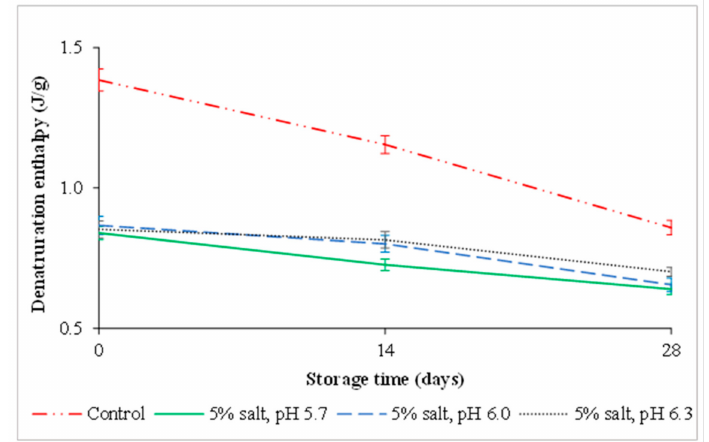
Figure 7. The effect of treatment on denaturation enthalpy of frozen-thawed liquid egg yolk. Data are presented with mean ± standard deviation.